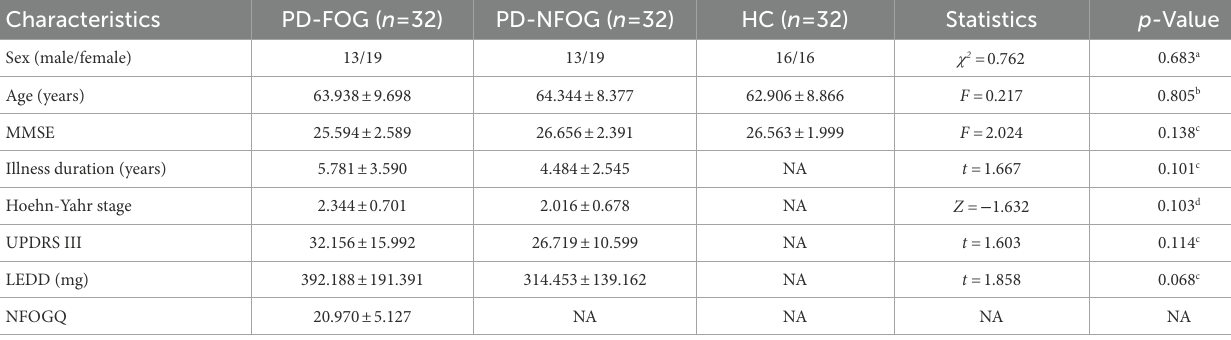
TABLE 1 Demographic and clinical